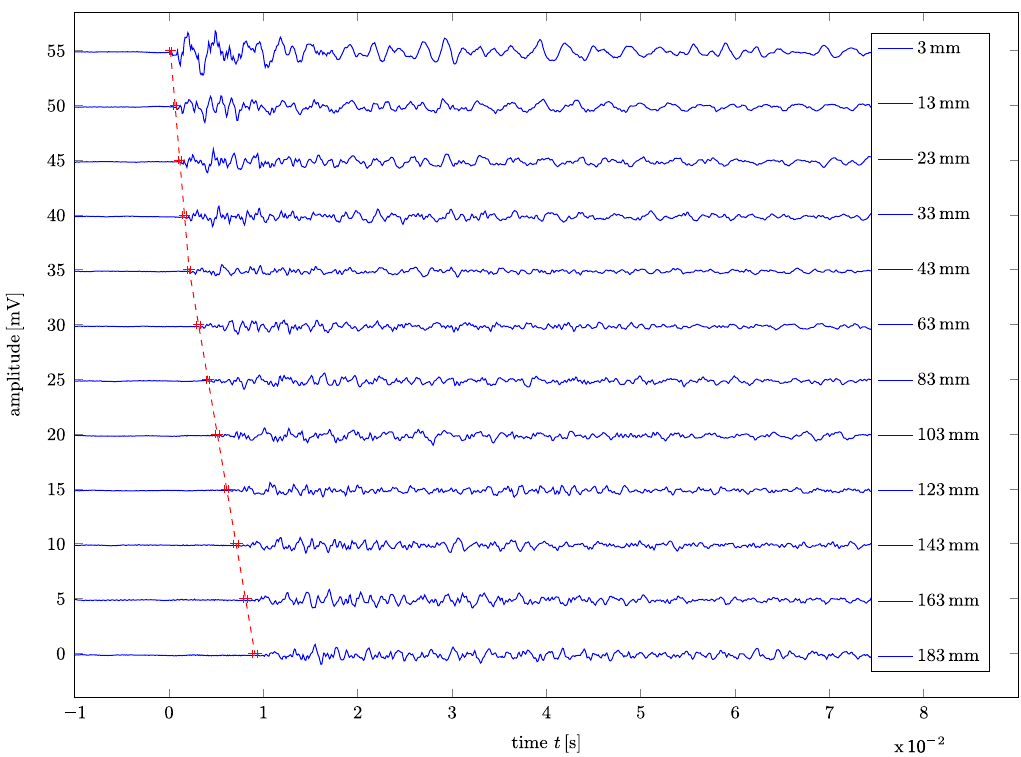
FIG. 8. 12 OST signals recorded in high resolution mode with increasing distance (given on the right side of each signal). The He level was 19.5 cm above the resistor. The red crosses mark the earliest and latest expected point for the Second Sound to reach the OST; the kink in the red dotted line is due to the change in the step size. All 12 signals are shown with the same scale for the amplitude, from (cid:5) 5 mV to þ 5 mV